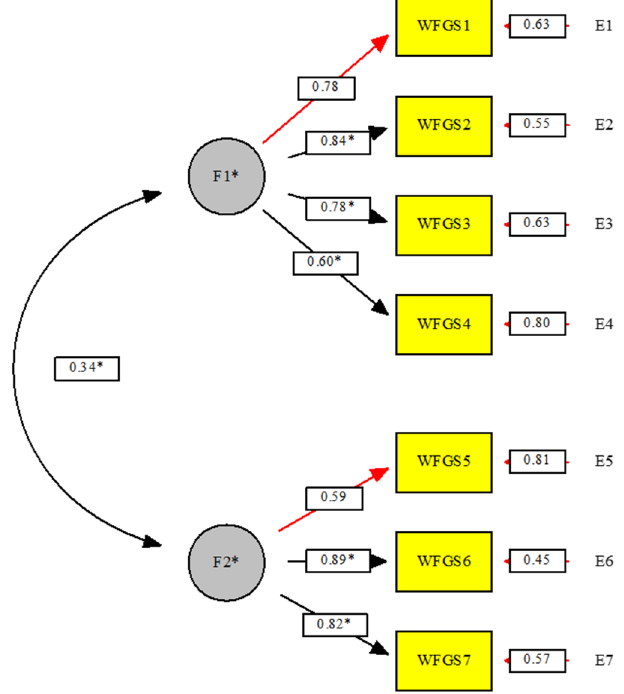
Figure 1. CFA standardized coefficients of the items in the WFGS. Note: * = p ≤ 0.05. In the multiple-group analysis, four progressively more restricted models were com- pared. The chi-squared differences were not significant between models 1 and 2 (0.33; p = 0.86), models 1 and 3 (5.78, p = 0.80), or models 1 and 4 (5.96, p = 0.87). In addition, the changes in CFI, NNFI, RMSEA, and SRMR were minimal in all the comparisons (see Table 2). Table 2. Multiple-group analysis of WFGS: configural, metric, and residual invariance. Table 3. Pearson correlations between WIFG and FIWG, antecedents, and outcomes variables. Brood. Refl. Stand. Disc.